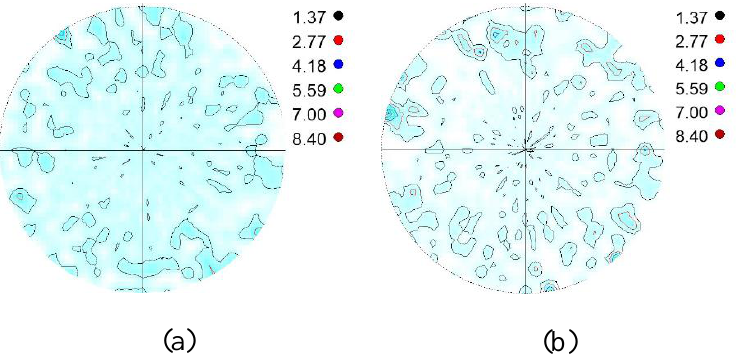
Figure 3. ( a ) α’{110} and ( b ) γ{111} pole figures of the powder mixture containing 72.6 % α’ (according to the Rietveld method).